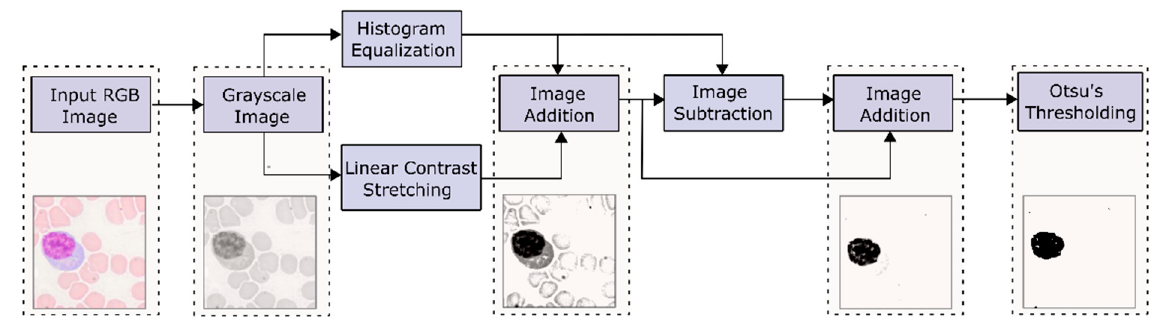
Figure 5. Segmentation process of lymphocyte nucleus.